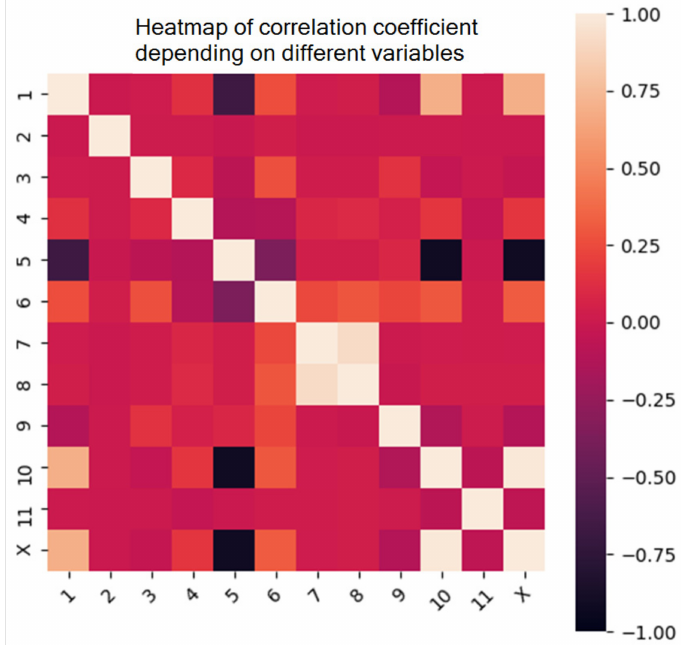
Figure 4. Heat map of Pearson’s correlation of data set used in the research.